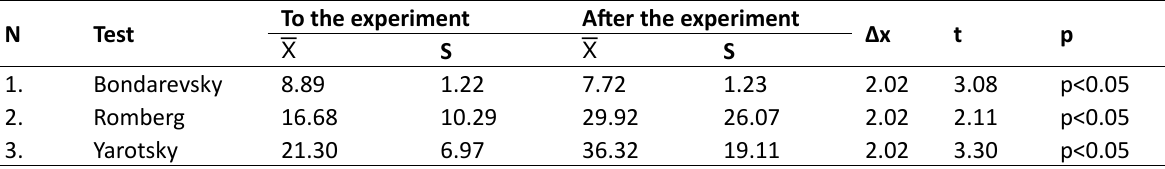
Table 1. Indicators of static balance of athletes in beach volleyball before and after the experiment (n = 20) To the experiment N Test